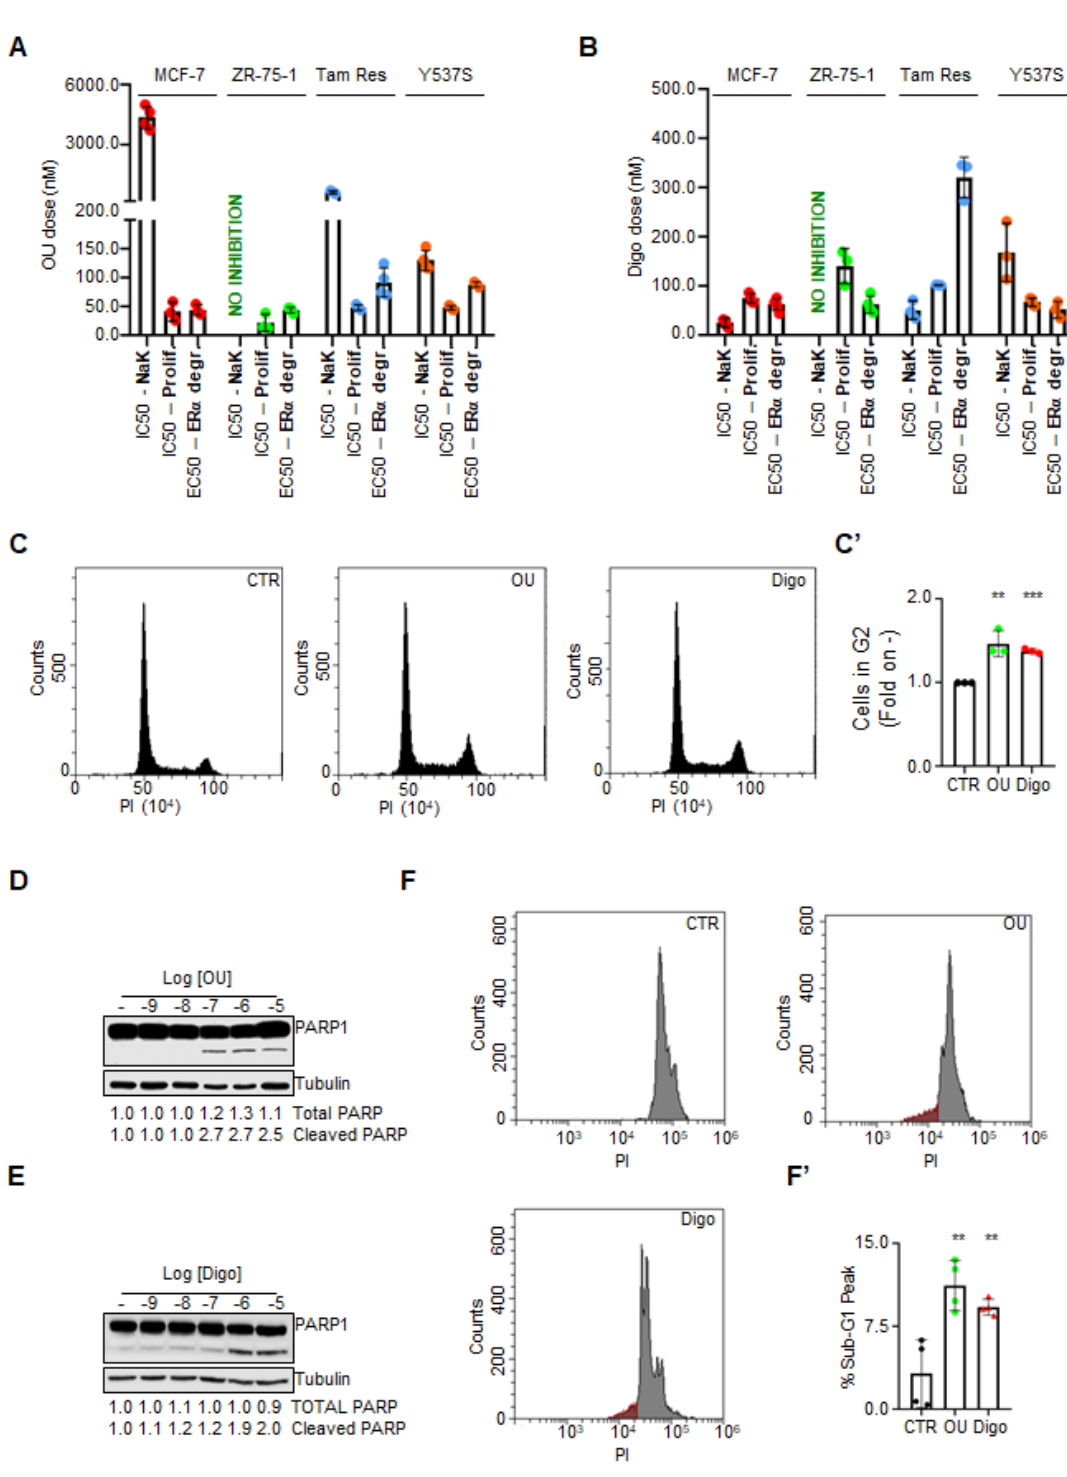
Figure 1. Effective concentrations analysis of the ouabain and digoxin effects on ER α expression, cell proliferation, and Na / K ATPase activity in breast cancer cells. ( A ) Effective dose 50 (ED 50 –nM) of ouabain (OU) for reduction in ER α intracellular levels in the indicated cell lines, calculated after 24 h of drug administration to each cell line; inhibitor concentration 50 (IC 50 –nM) of OU for cell proliferation in the indicated cell lines, calculated after 5 days of treatment for each cell line; IC 50 (nM) for OU for Na / K ATPase activity in the indicated cell lines, calculated after 24 h of treatment for each cell line. ( B ) ED 50 (nM) of digoxin (Digo) for the reduction in ER α intracellular levels in the indicated cell lines, calculated after 24 h of drug administration to each cell line; IC 50 (nM) of Digo for cell proliferation in the indicated cell lines, calculated after 5 days of treatment for each cell line, and IC 50